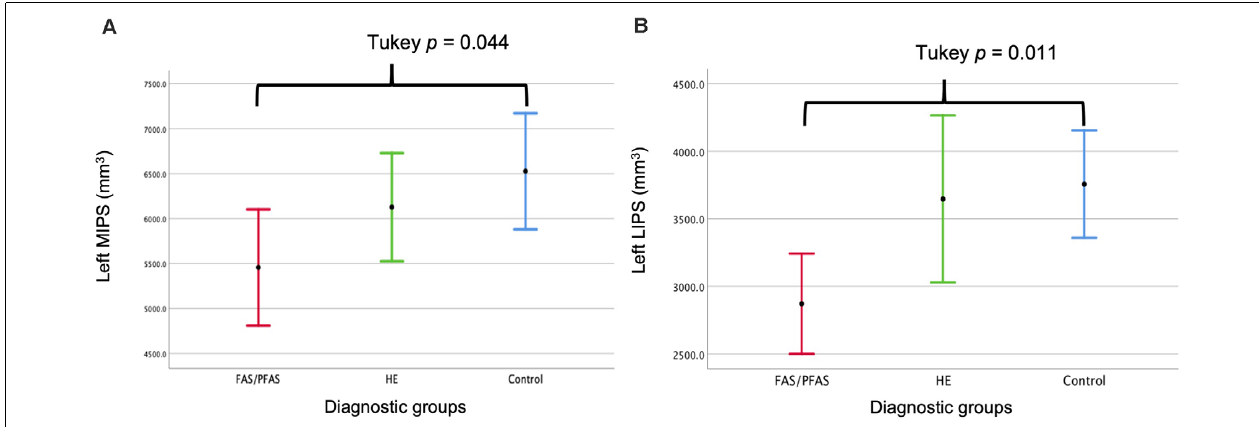
FIGURE 2 | Comparison of the (A) left medial (M) and (B) left lateral (L) IPS volumes by diagnostic group (mean ± 95% Confidence Intervals).